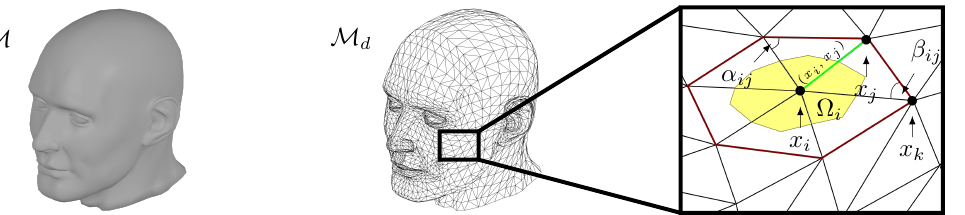
Figure 3. ( Left ) The 2D Riemannian manifold of the centaur’s head. ( Middle ) The discrete M approximation of this manifold. is displayed via the point cloud and the triangles . M d M d P T ( Right ) The setting for the calculation of the LBO around the point x i . The yellow area indicates the cell volume Ω i . Additionally, we see the two angles α ij and β ij opposite to the edge ( x i , x j ) (green